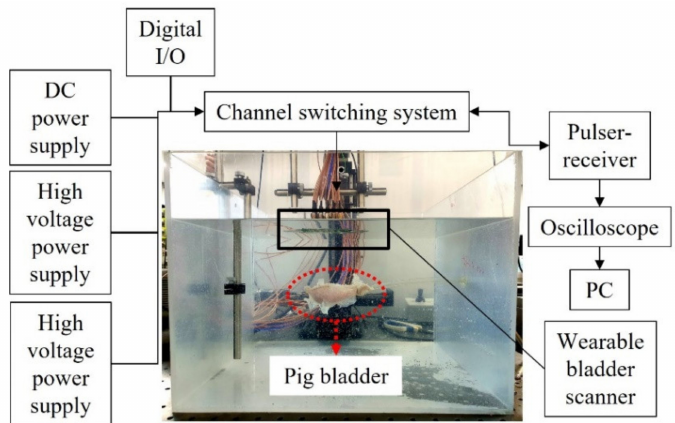
Figure 5. Experimental setup for the measurement of pig bladder wall position.